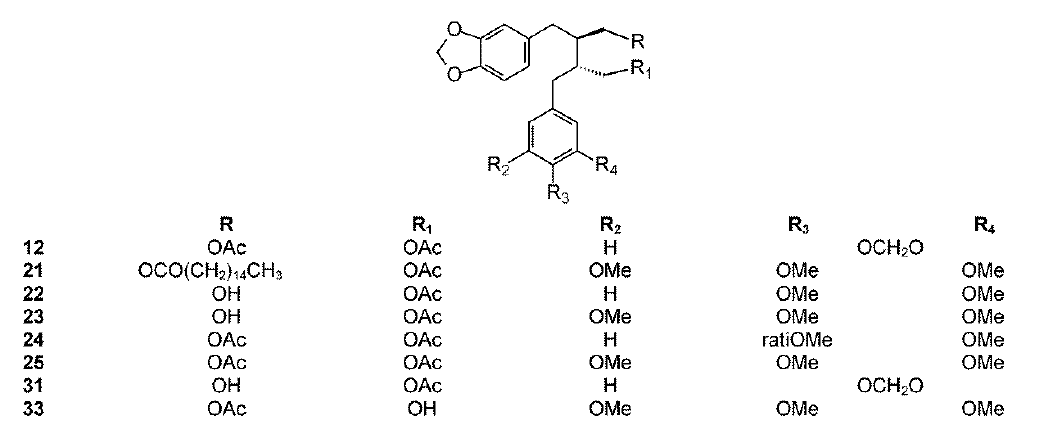
Figure 5. Dibenzylbutane diol lignans isolated from Bursera spp.